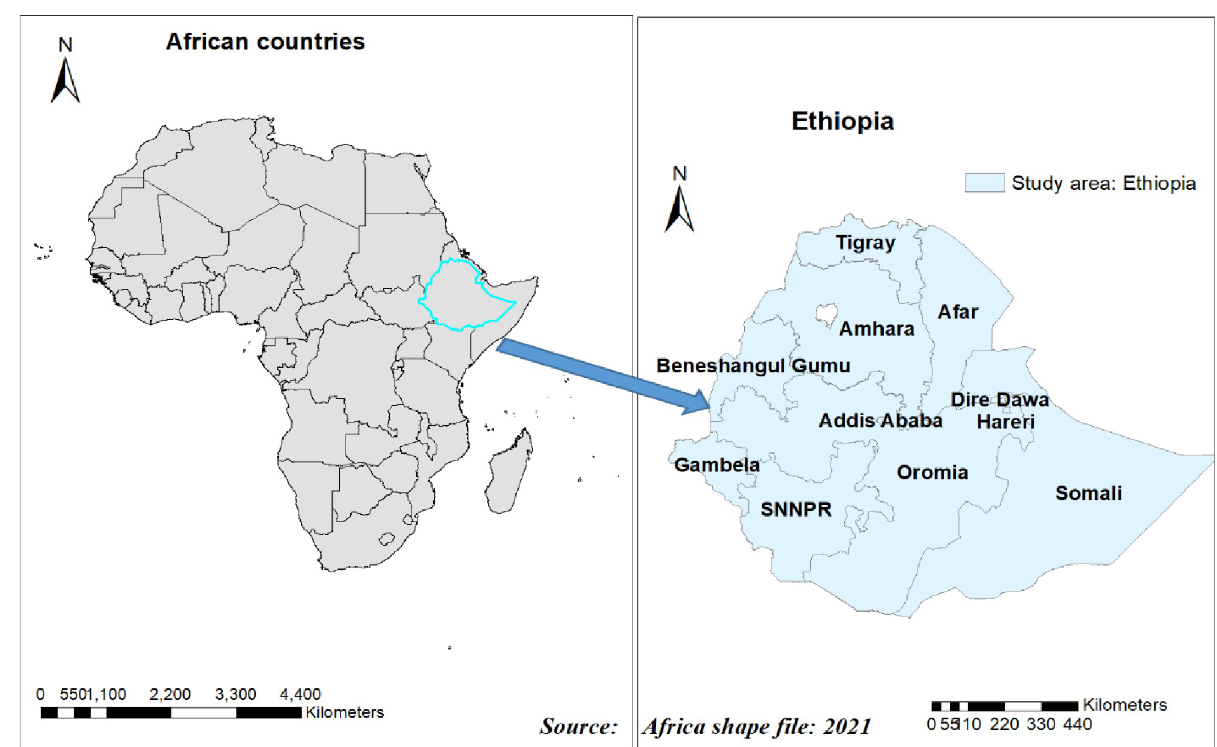
Fig 1. Map of Ethiopia where the surveys were undertaken within nine regions and two cities administrate plotted using ArcMap 10.7.